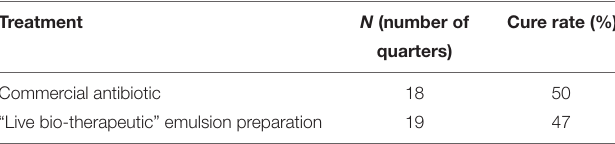
TABLE 2 | Cure rates for the commercial antibiotic control and the ‘live bio-therapeutic’ preparation in emulsion. Treatment N (number